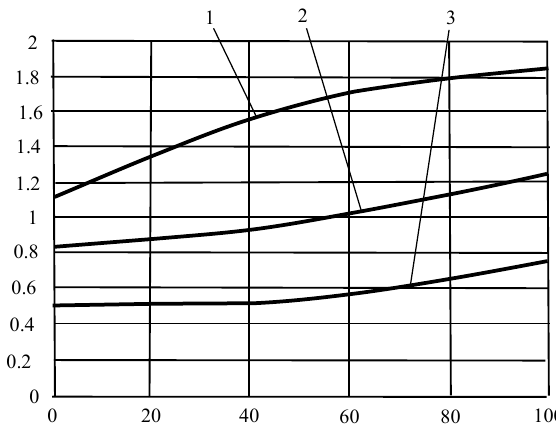
Fig. 11. Visualization of the average values of vertical displacements of the sprung weight on the test-bench: 1) without a pendulum; 2) with a pendulum at various lengths of the arm – 0.0751 m (2) and 0.125 m